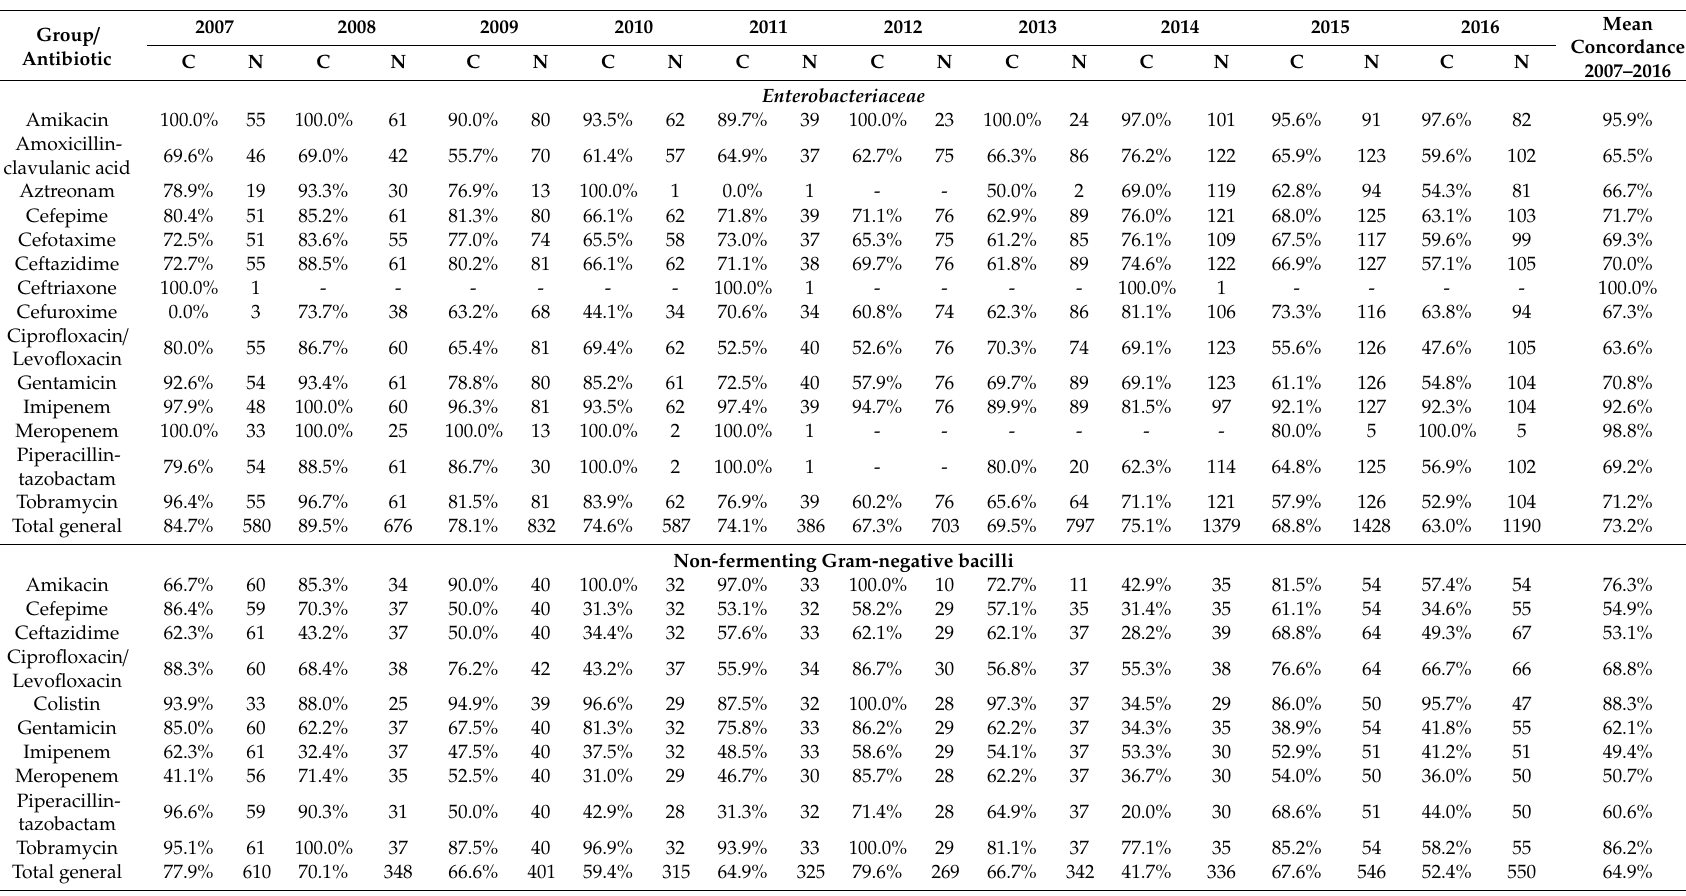
Table 1. Percentage concordance between bacterial susceptibility shown by LRMs and susceptibility obtained from antibiograms by year, bacterial group, and